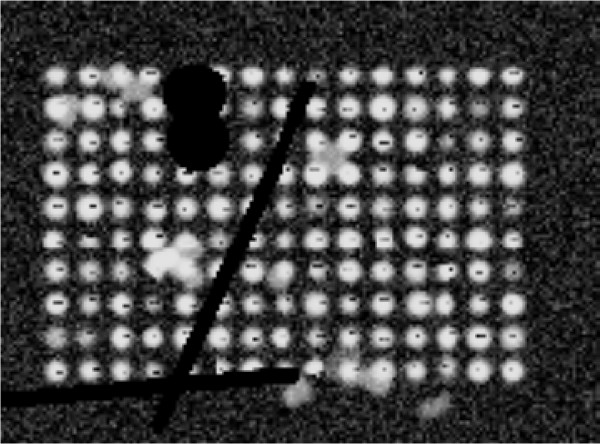
Hybridization errors. Hybridization errors are demonstrated. Spot bleeding, scratches, air bubbles and background noise are clearly visible.